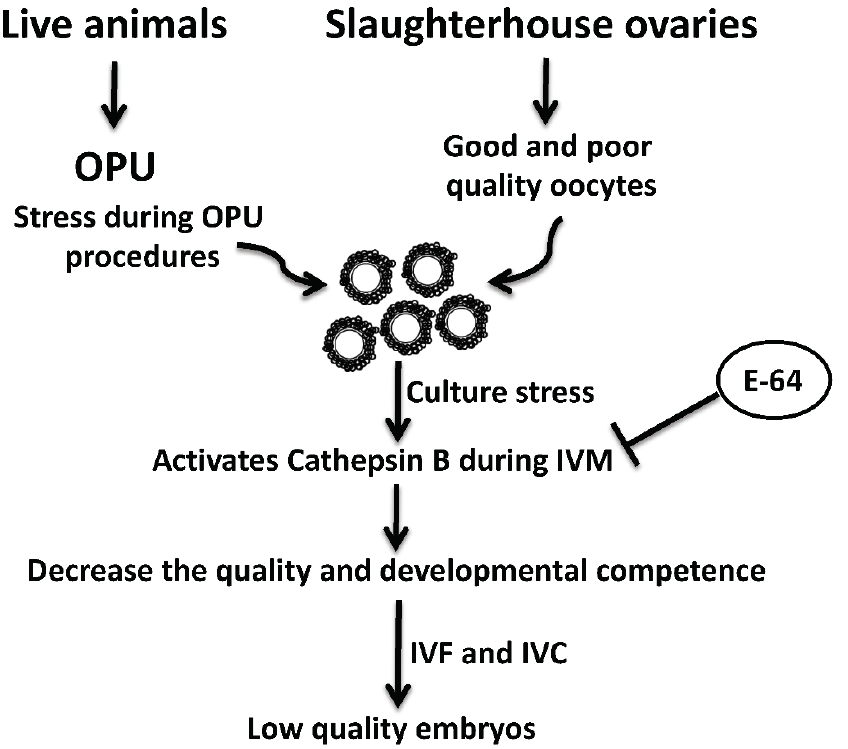
Figure 4. Schematic diagram of the role of cathepsin B and its inhibition by E-64 on the developmental competence and quality of bovine oocytes recovered by ultrasound-guided ovum pick-up technique.